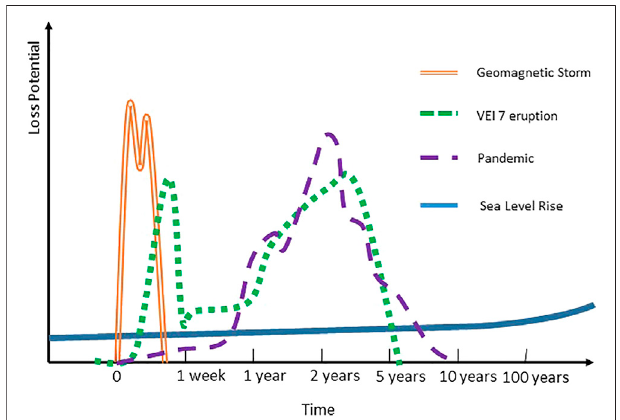
FIGURE 3 | 4 Global GCRs – a schematic of the duration of the physical event initiating four global catastrophes and loss potential. Note the time intervals per unit width on the X-axis vary from 1 week to 90 years. The Y-axis Loss Potential scale has no units here; it encompasses the potential consequences in the fi ve lower boxes on Figure 1